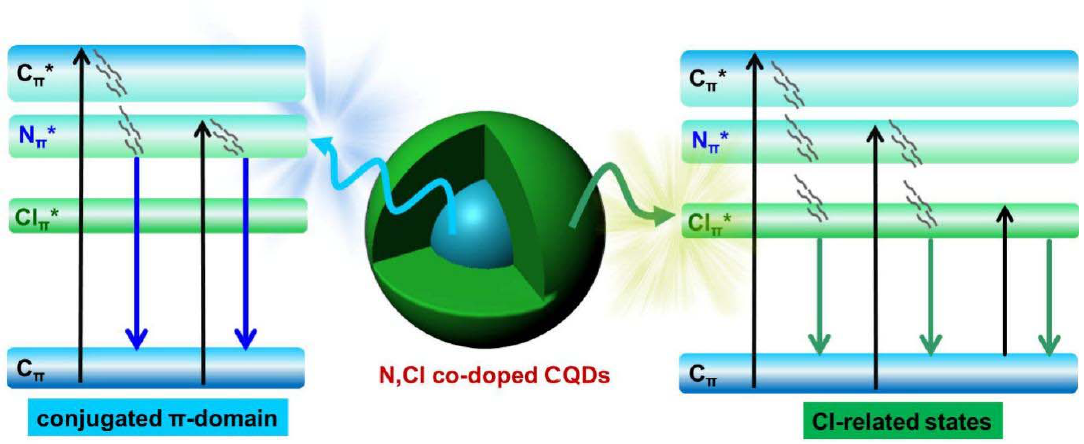
Figure 14. The speculated energy level diagram of the nitrogen and chlorine co-doped CQDs.